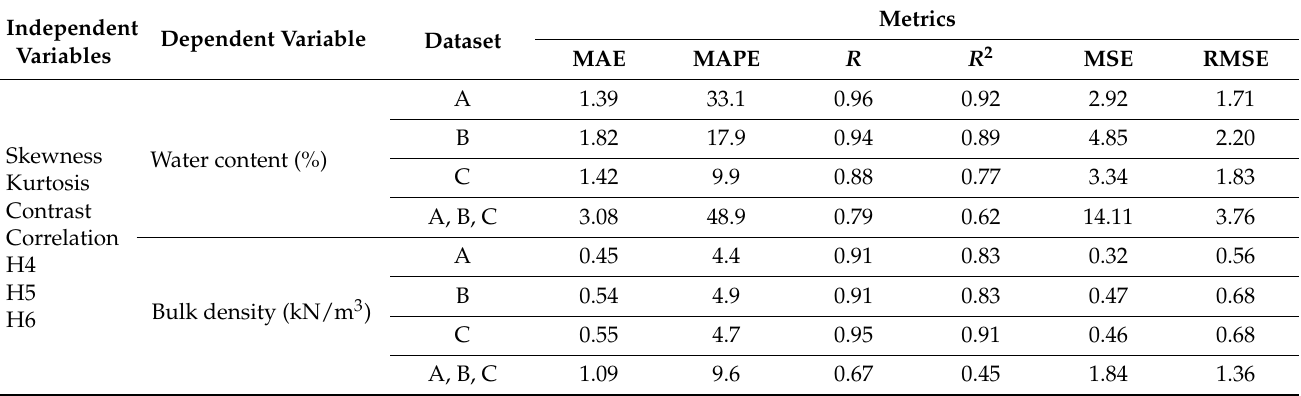
Table 6. Result of multiple regression analysis using features from soil surface images.